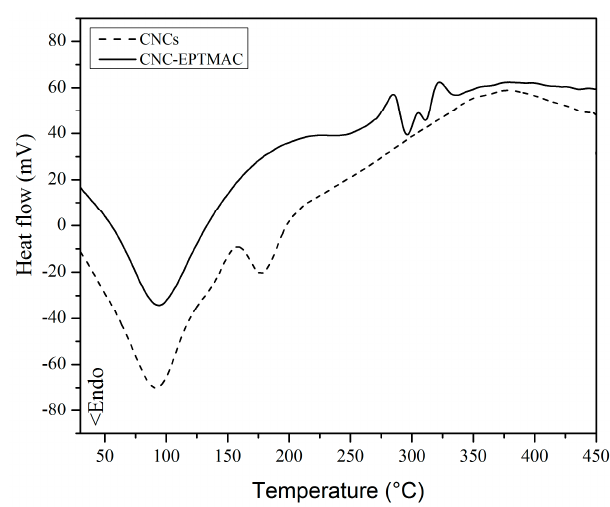
Figure 6. Differential scanning calorimetry analysis of CNCs (dotted line) and CNC-EPTMAC (unbroken line).